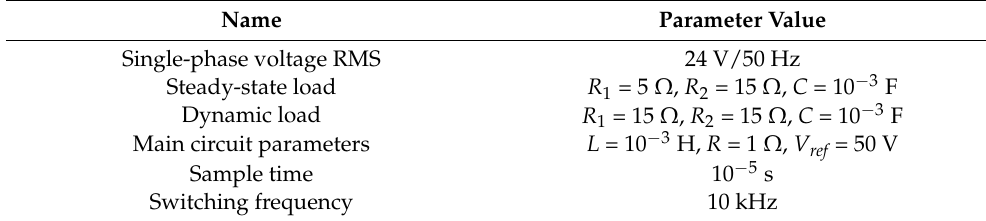
Table 1. Simulation parameters of APF.